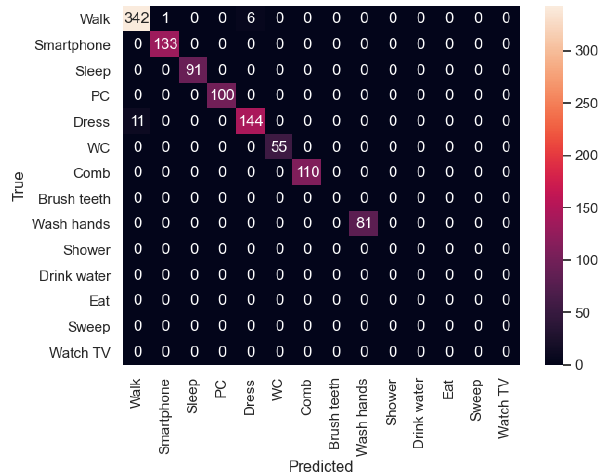
Figure 24. Sequence 1-Experiment 2-Confusion